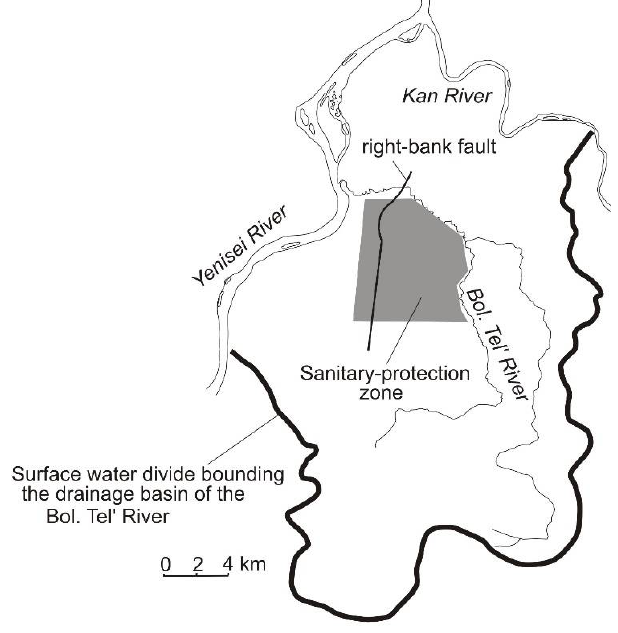
Figure 2. Location of the injection site for the disposal of LRW from MCP.